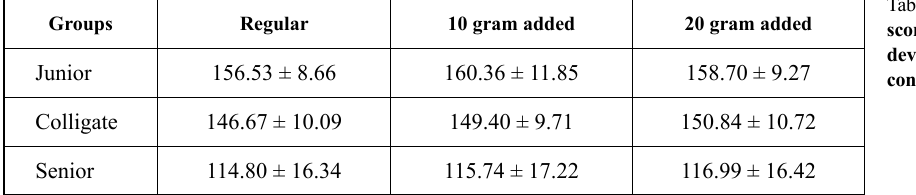
Table 2. Serve speed (km ·h -1